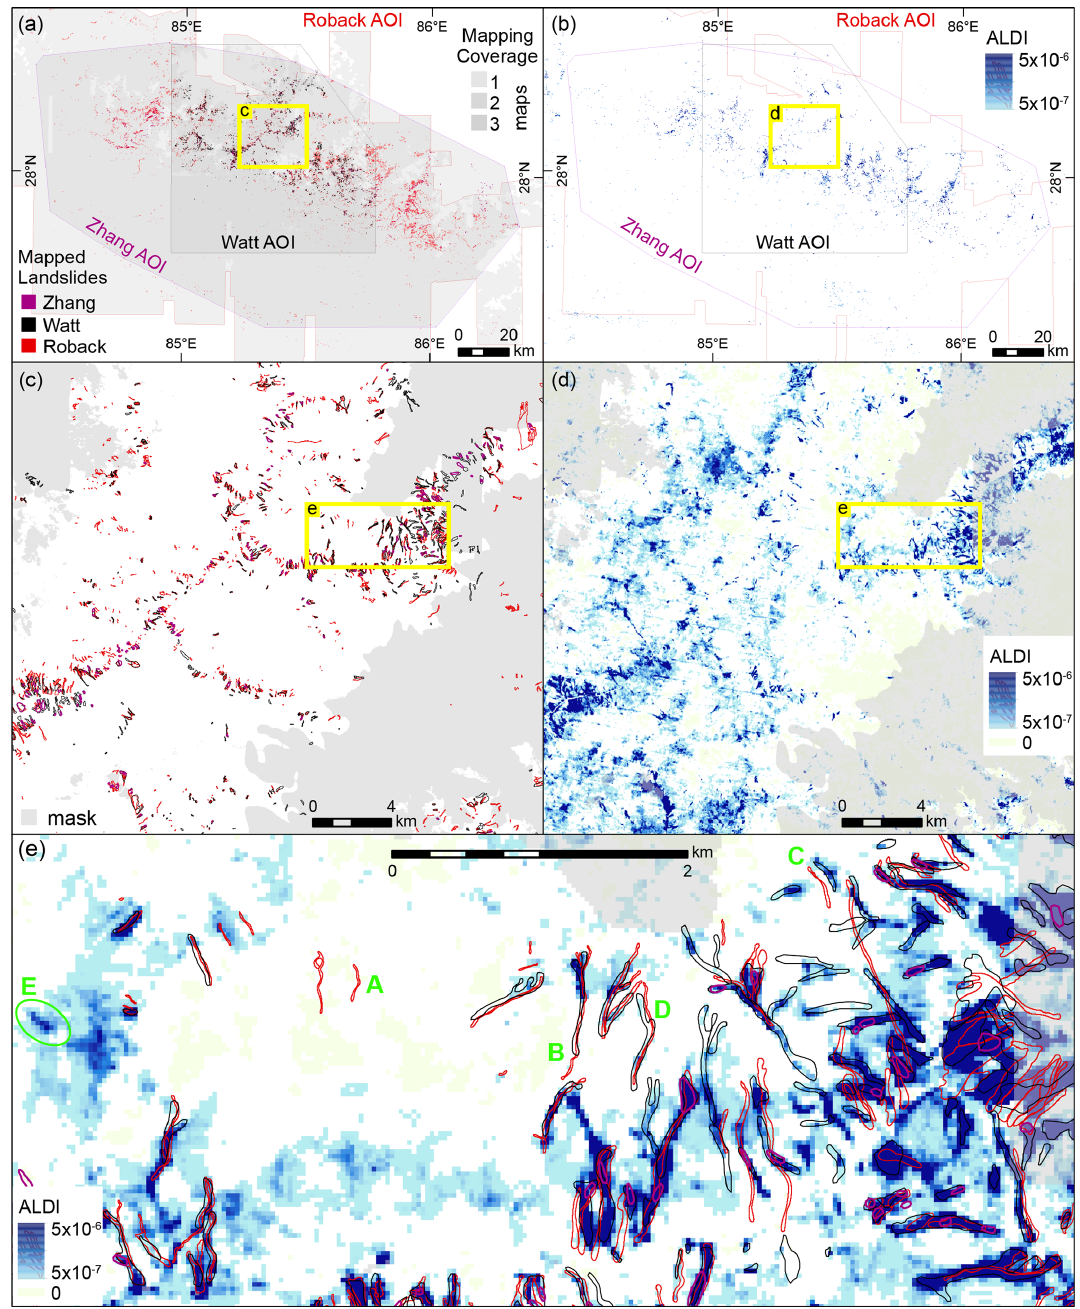
Figure 2. Mapped landslides and the ALDI classifier for the Gorkha study site. (a) Mapped landslides at the scale of the full study area with AOIs (areas of interest; the mapped area) shown in grey. Zhang, Roback, and Watt refer to the inventories of Zhang et al. (2016), Roback et al. (2018), and Watt (2016). (b) ALDI values for the full study area, using locally optimised parameters. (c) Mapped landslides from the three inventories for a subset of the study area, with areas that were unmapped in one or more inventory shaded grey. (d) ALDI values using locally optimised parameters for the same subset of the study area shown in (c) . (e) Detailed view of mapped landslides from the three inventories and ALDI values. Yellow boxes in each panel show the locations of nested panels (e.g. c in a and d in b ). Green labels in (e) indicate examples of (A) missed landslides, (B) agreement between inventories, (C) offset landslide outlines, (D) distorted landslide outlines, and (F) landslides identified by ALDI but missed by manual